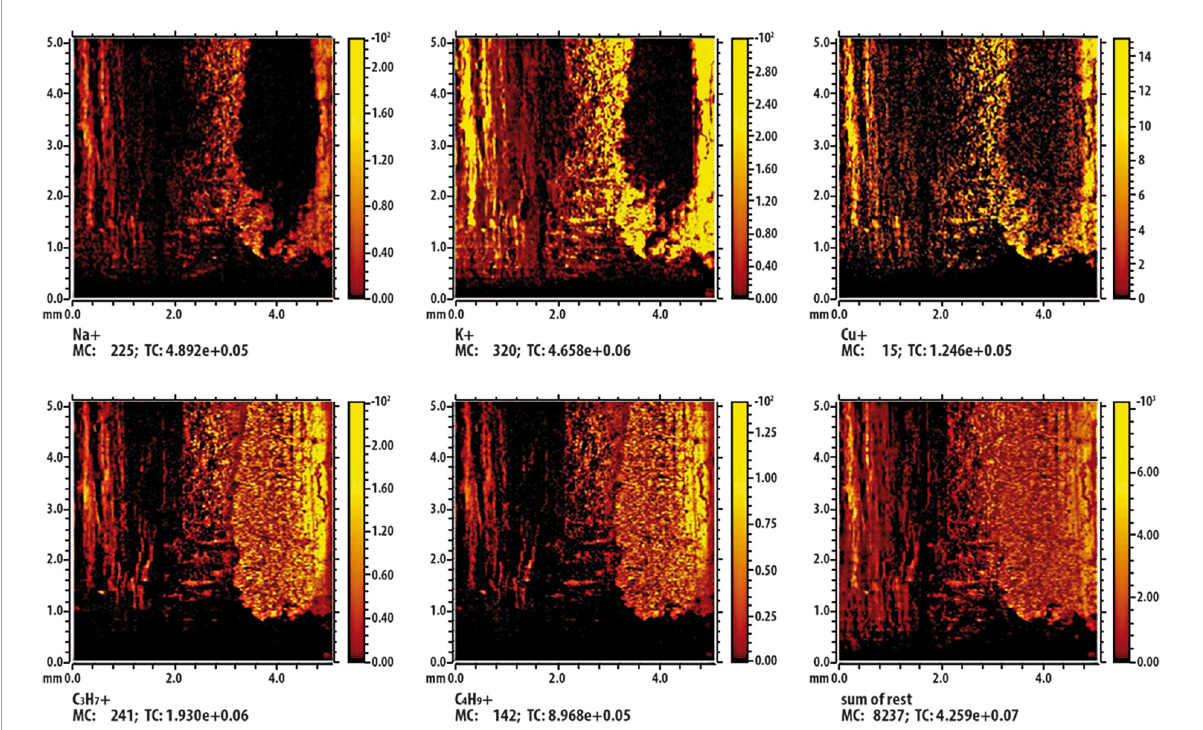
FIGURE10 Time-of-flight secondary ion mass spectrometry (ToF-SIMS) false-color image of some characteristic ions on the surface of the twig section being in contact with Cu containing super absorbent polymer (SAP) containing copper (SAP-Cu). The inset labeled “sum of rest” represents the sum of the other signals present in the spectrum but not shown in the